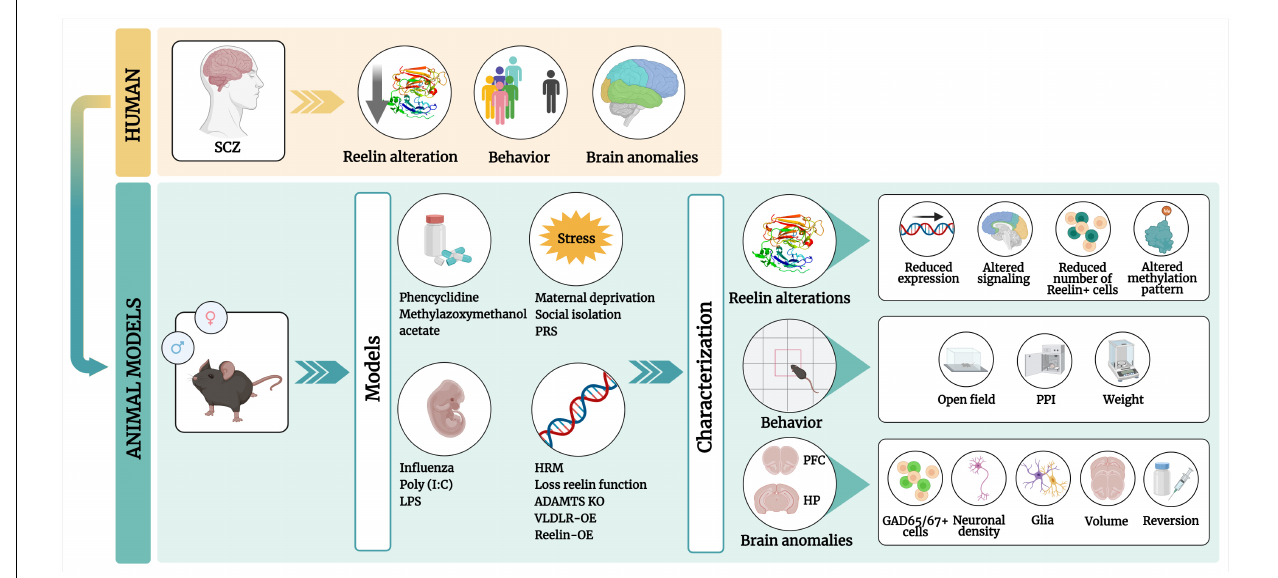
FIGURE 1 | Graphical abstract of this review. Patients with schizophrenia (SCZ) have low RELN levels in the brain, with behavioral defects and brain anomalies. These phenotypes can be mimicked in pharmacological, maternal immune activation, stress, and genetic rodent models. These models include four types of RELN alterations, behavioral phenotypes [in the open field and prepulse inhibition (PPI) tests] and brain anomalies in the prefrontal cortex (PFC) and the hippocampus (HP) (regions). PCP, Phencyclidine; MAM, methylazoxymethanol; Poly(I:C), polyinosinic:polycytidylic acid; LPS, lipopolysaccharide; PRS, prenatal restraint stress; HRM, heterozygous reeler mouse; OE, overexpression. Created with